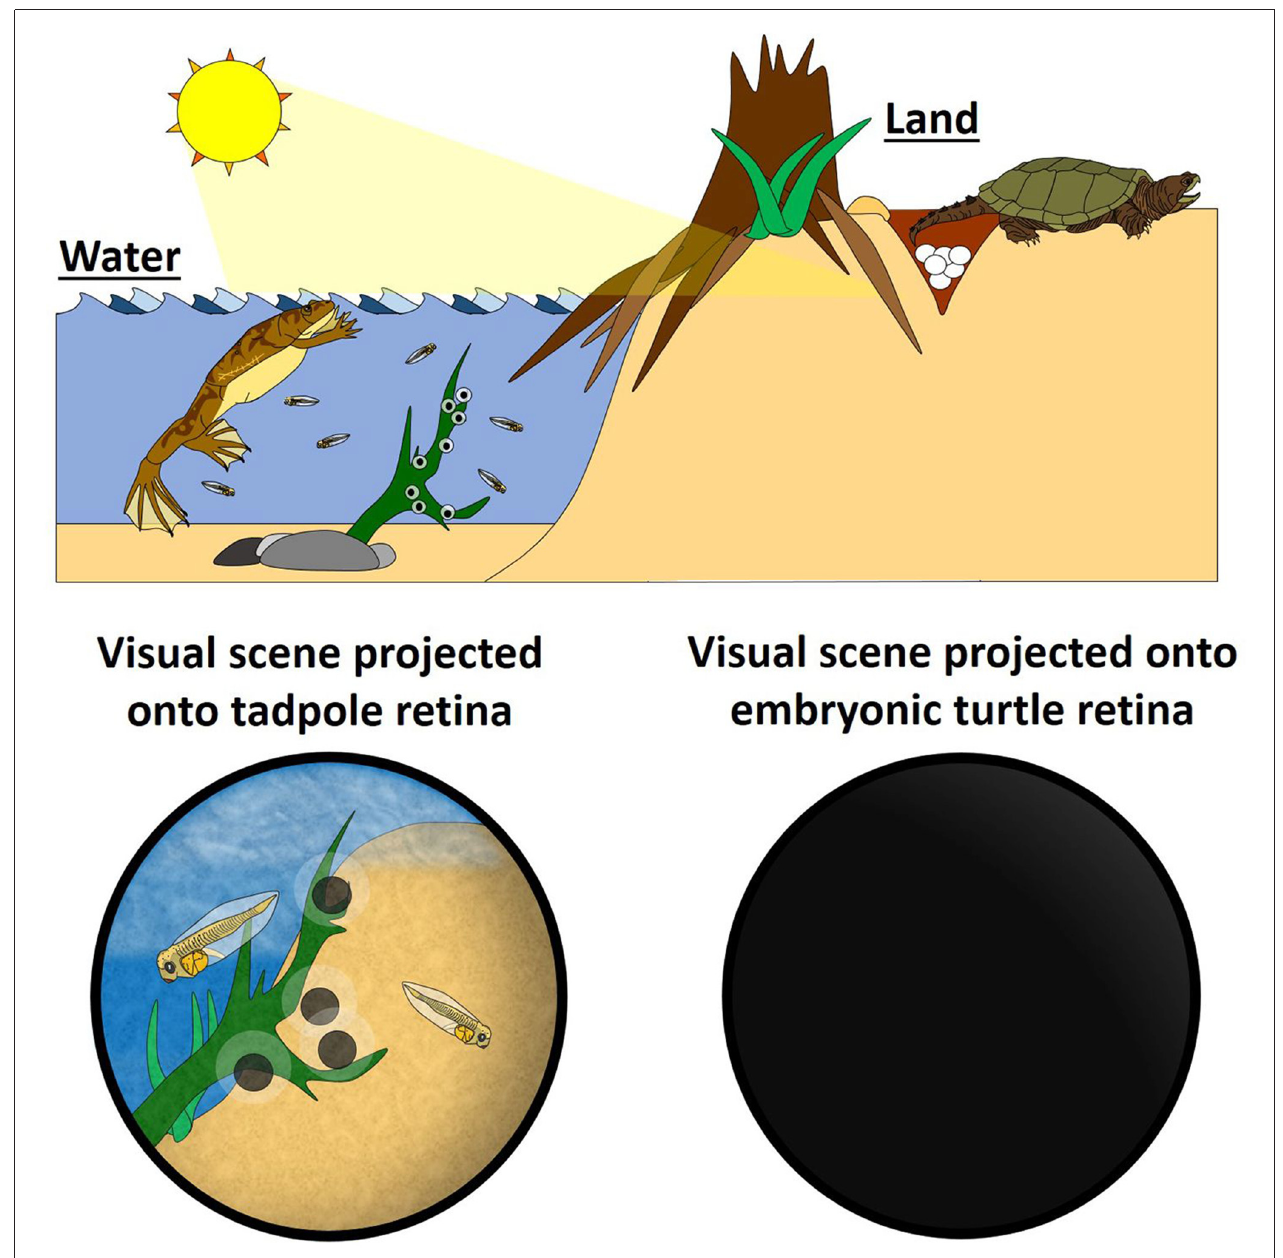
FIGURE 1 | Retinal waves could be an evolutionary adaptation for visual systems developing in the absence of visual stimuli. (Left) In the water, fertilization of fish and aquatic amphibians takes place externally, so the embryos develop with the benefit of direct sensory stimuli. This natural visual stimulation activates retinal ganglion cells (RGCs), providing the activity for activity-dependent mechanisms that instruct the formation and maturation of the visual system. Retinal waves are not needed to generate RGC activity in anamniotes, and, consistent with this, the anamniote retina does not express retinal waves. (Right) On land, development of amniotes—by definition—takes place in utero or in ovo, and so these embryos do not experience natural visual scenes. RGCs still get activated, however, by self-generating spontaneous waves of activity (Schematic by Harley